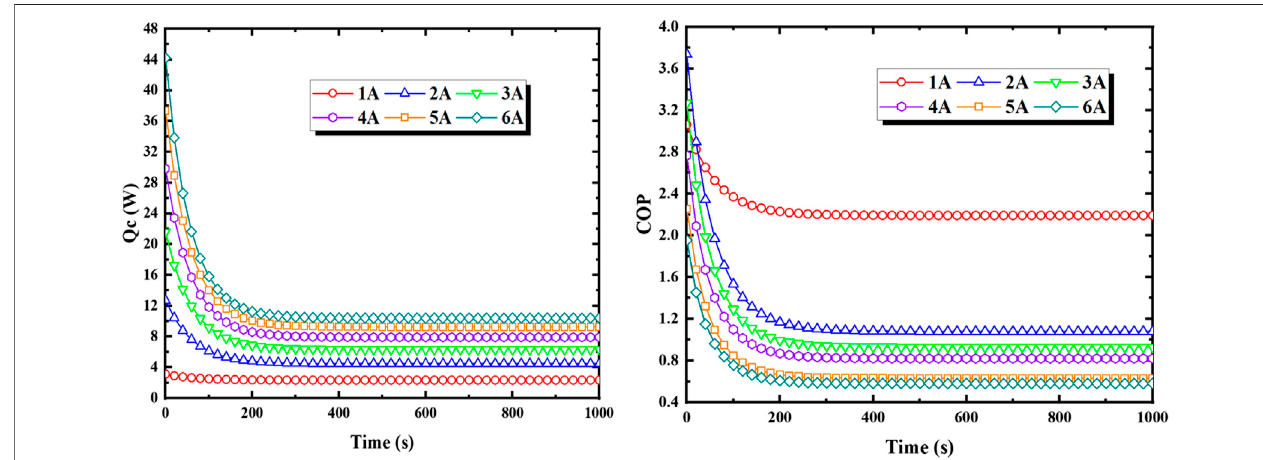
FIGURE 3 | The variation of Single-chip TEM cooling power and COP with time in different currents.